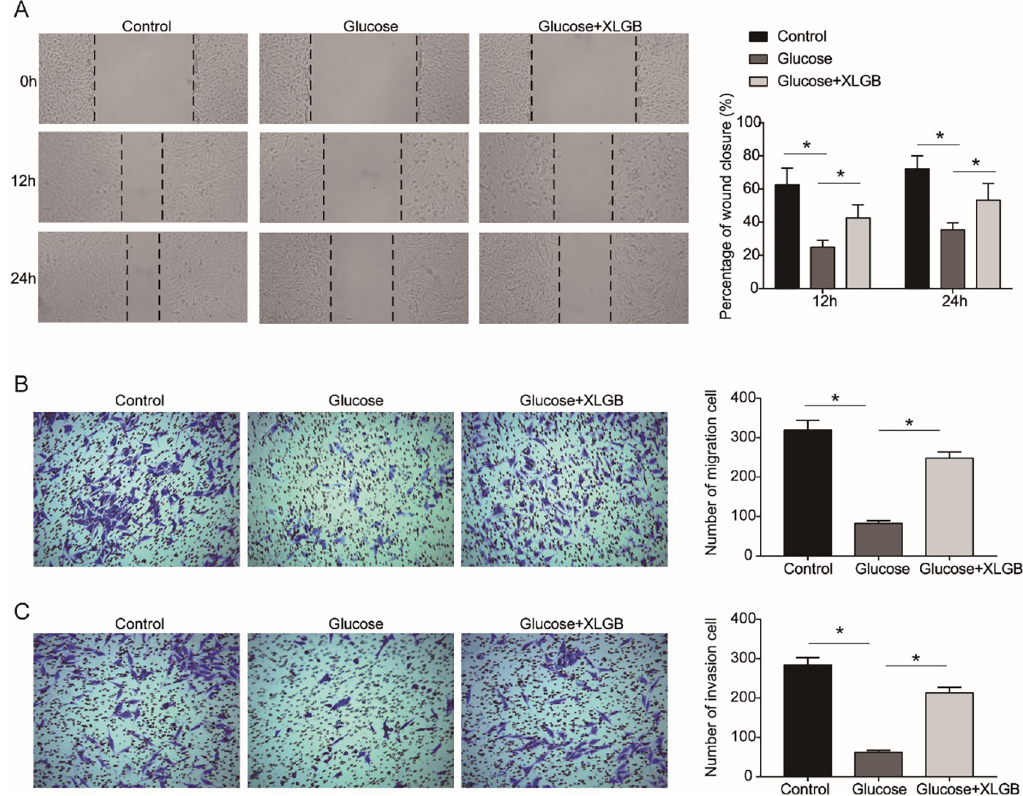
Fig 5. XLGB rescues the reduced the migration and invasion abilities of MG63 cells caused by high glucose. A. Cell migration was assessed by wound-healing assay in MG63 cells post treatments with control, high glucose and high glucose +XLGB. B, C. Transwell assay was performed to determine the migration (B) and invasion (C) abilities of MG63 cells. Control, cells treated with mannitol; Glucose, cells treated with 20 mM of glucose; Glucose +XLGB, cells treated with 20 mM of glucose plus 200 mg/L of XLGB. Data represented mean ± SD of three separate experiments. � P <